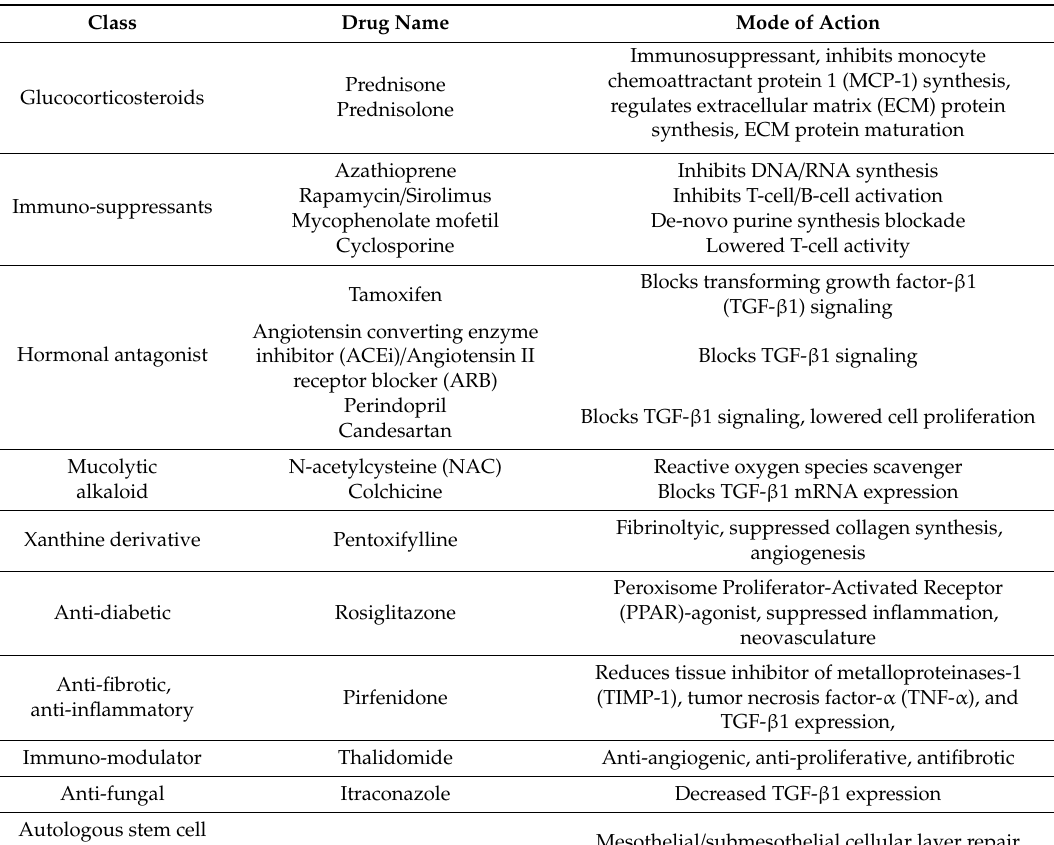
Table 1. Overview on currently applied and experimental pharmacological treatments in